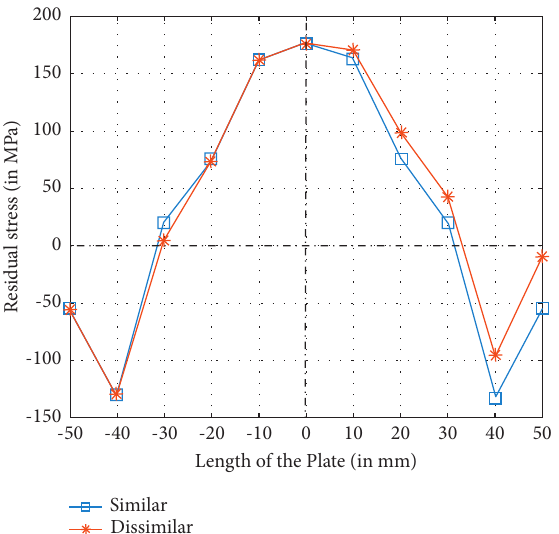
Figure 18: Residual stresses vs. length of plate in double V groove (level-5) weld specimen.